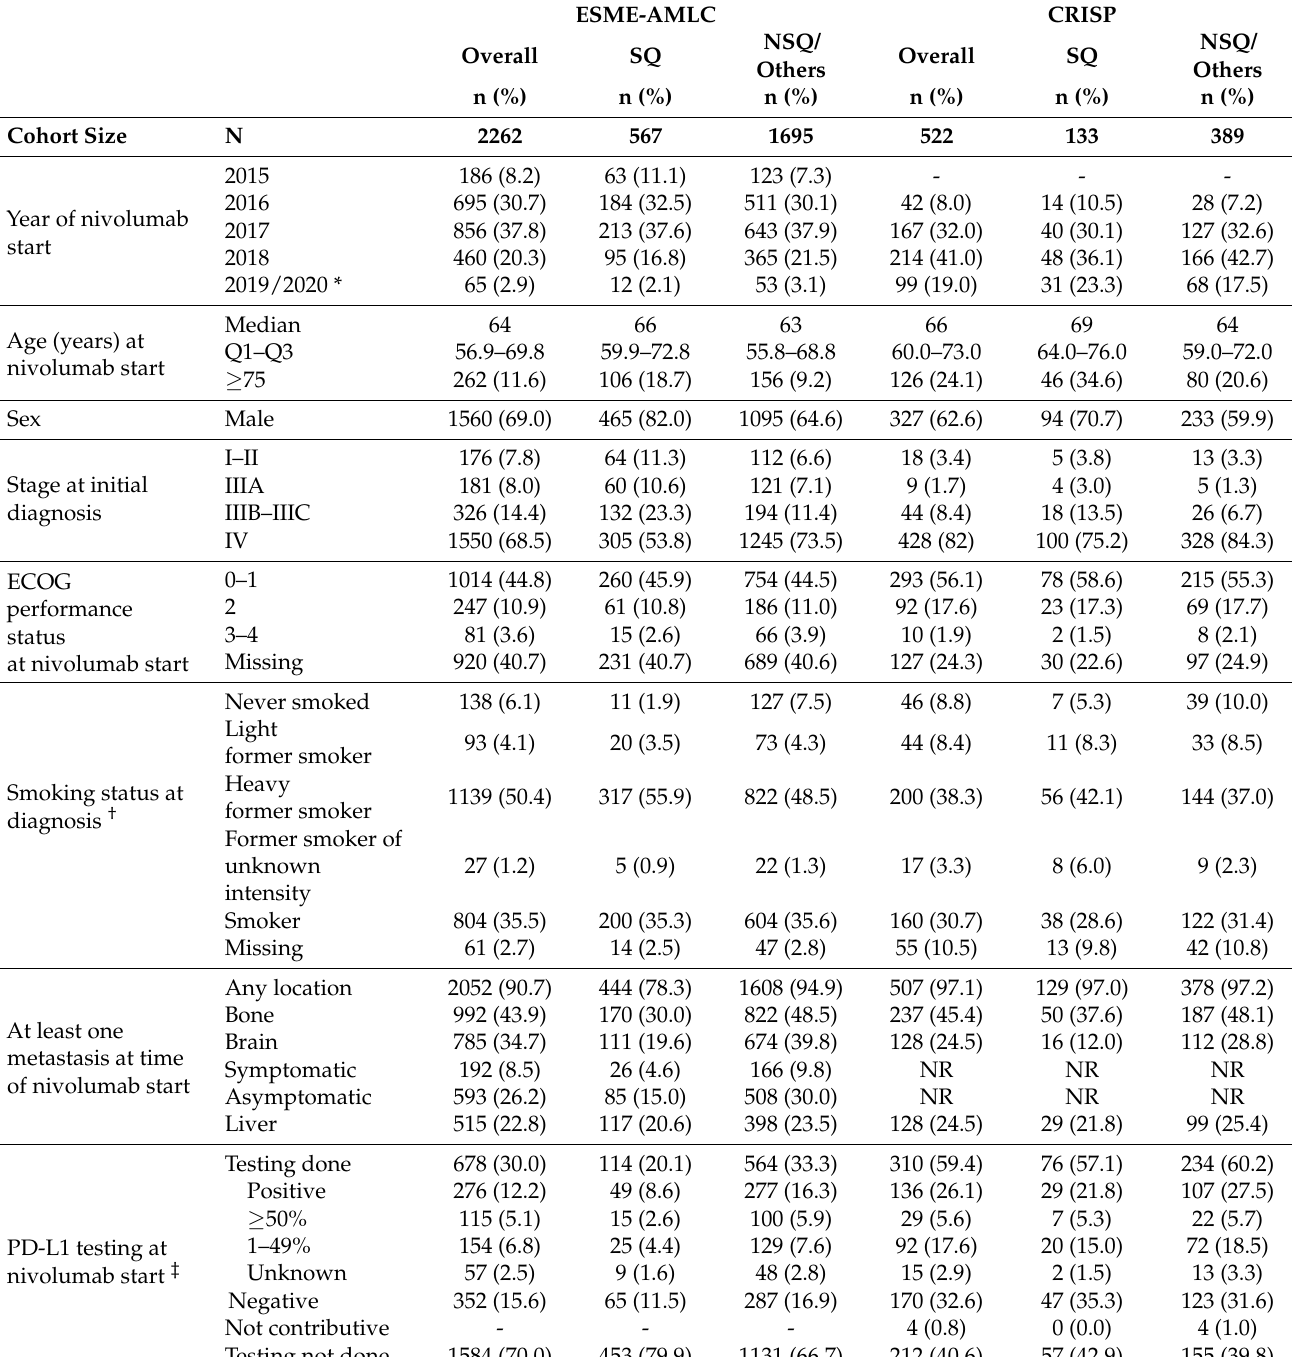
Table 1. Demographics and clinical characteristics of patients with NSCLC treated with nivolumab in 2L+, overall and by histology in the ESME-AMLC and CRISP